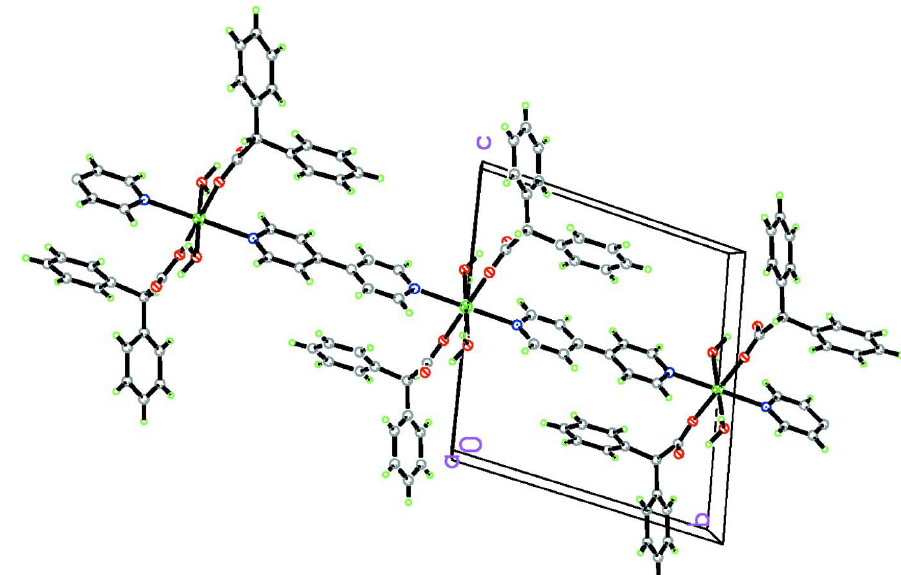
Figure 2 Part of the one-dimensional chain structure of